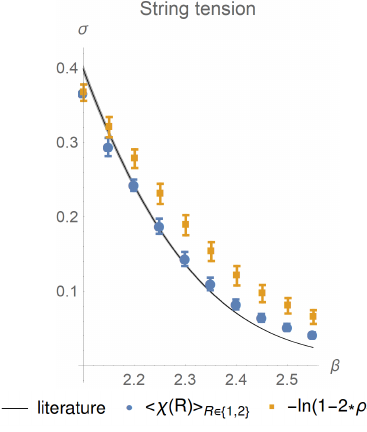
Figure 9. Comparison of the string tension calculated via Creutz ratios in the projected configuration and calculations based on the vortex density with the literature